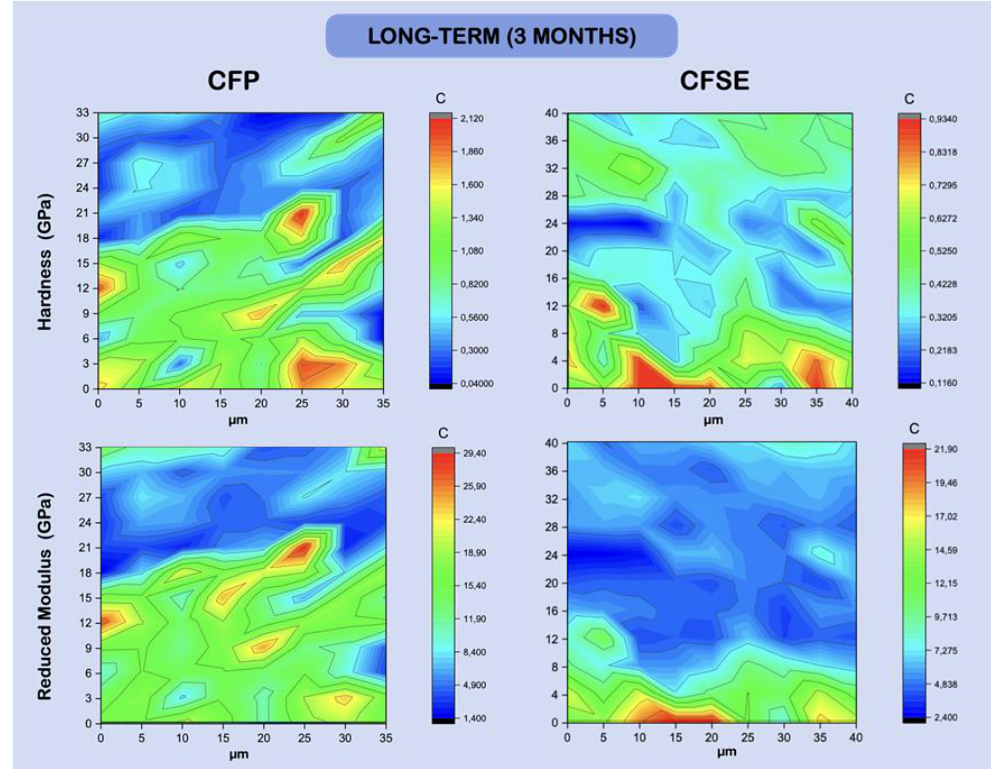
Figure 3. Hardness and reduced Young’s modulus (GPa) maps, showing the variation in intensity for each of the variables, across an area, mapping the resin-dentin interface after being restored and stored for 24 h in deionized water. Dentine is shown at the bottom, easily identifiable by the higher modulus values, while the hybrid layer is directly after (maps are representative of one random sample). Distance between points is shown in μ m.